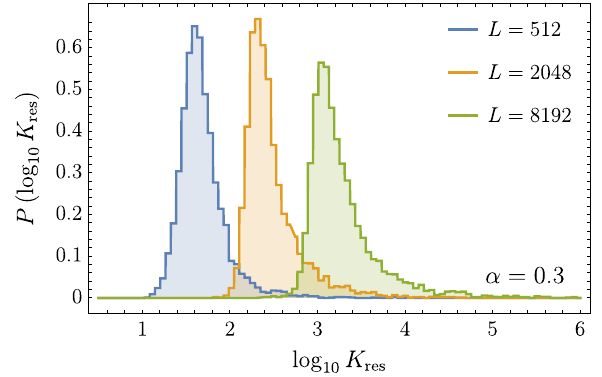
FIG. 21. The probability distribution P ð log 10 K